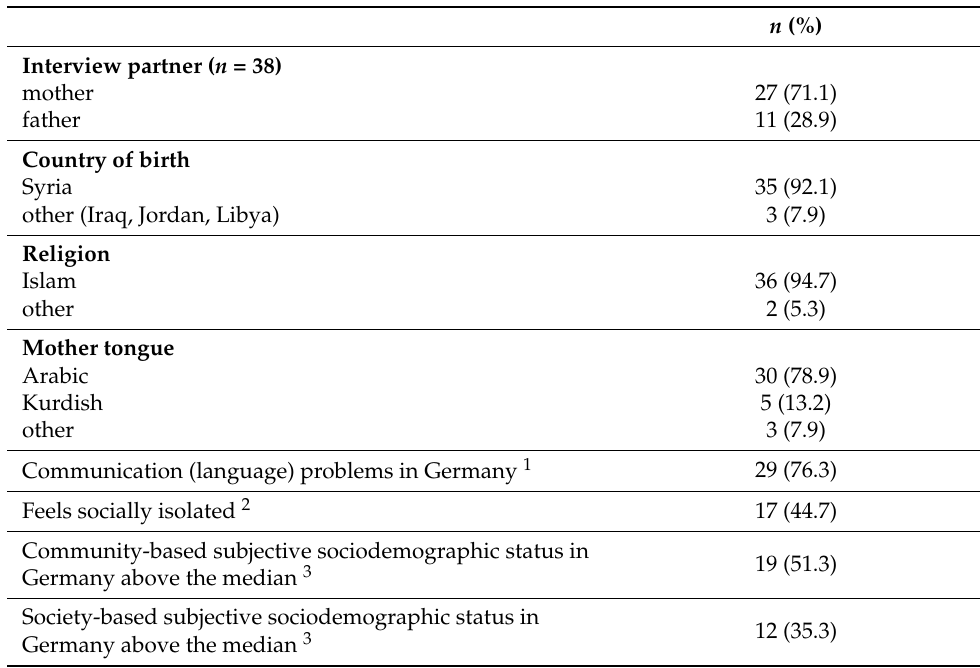
Table 2. General characteristics of the parent who was